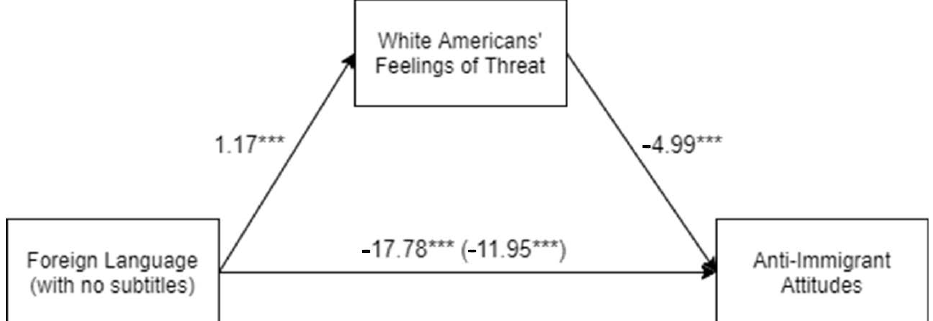
Figure 2. Mediation model for the relation between exposure to foreign language with no subtitles and anti-immigrant attitudes (Study 2). Note : Statistics for each path are unstandardized estimates. The unstandardized estimate in parentheses is the direct effect of foreign language with no subtitles on anti-immigrant attitudes, controlling for White Americans’ feelings of threat. *** p < 0.001.